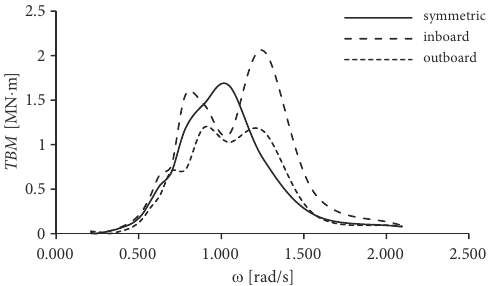
Figure 11. RAOs of transverse bending moments TBM in head seas